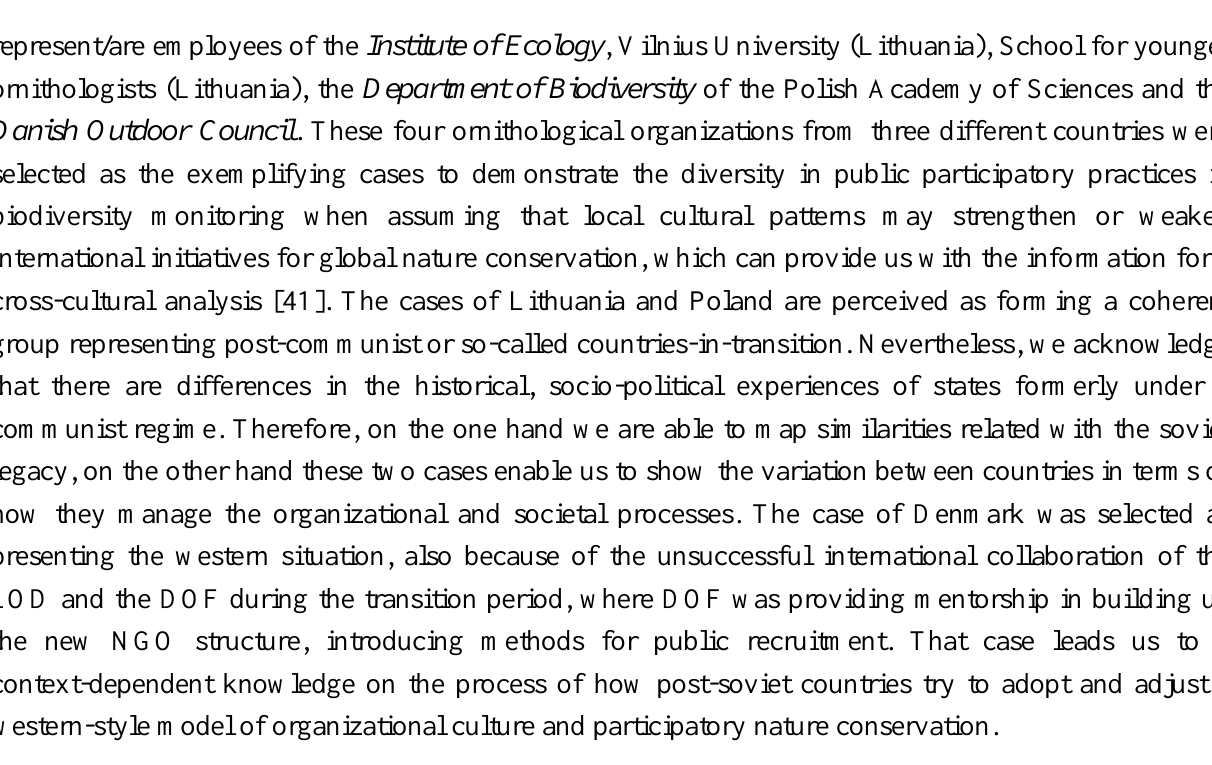
Table 1. Short descriptions of the studied